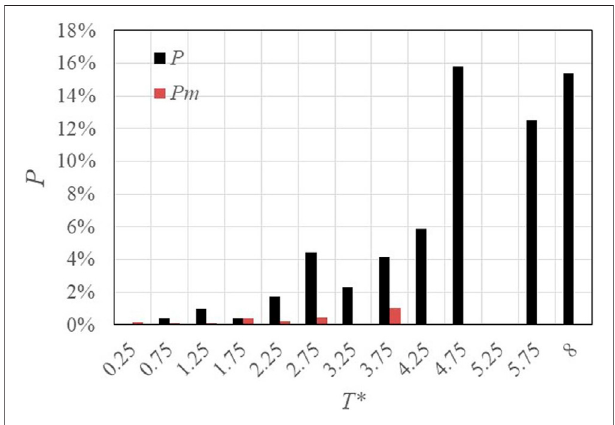
FIGURE1| Injuryandmortalityprobabilityversusthedimensionlesstime T* for water wheels (Quaranta and Wolter, 2021).